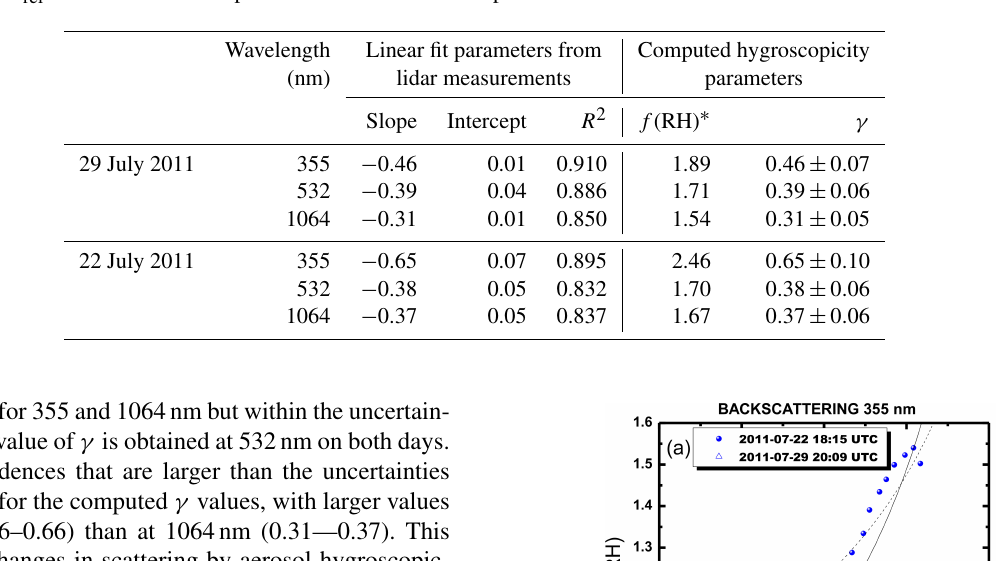
Table 1. Results of the linear fits of log( f (RH)) versus log((1-RH) / (1 / RH ref ) ). The computation of f (RH) ∗ was done using Eq. (5) with RH = 80% and RH ref = 20% for intercomparisons with a tandem of nephelometers.